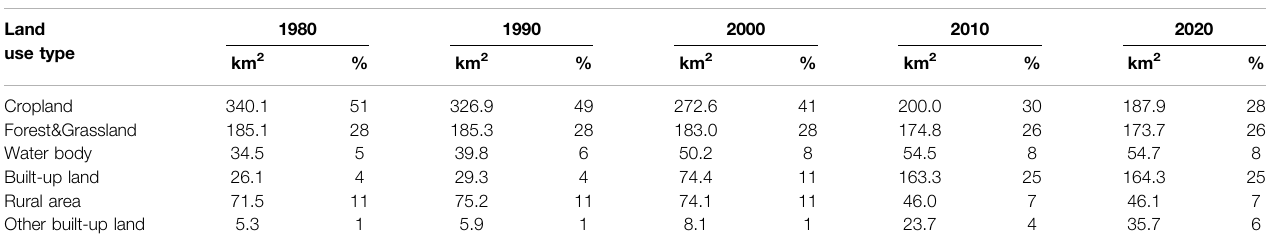
TABLE 1 | Land-use changes in Baiyun